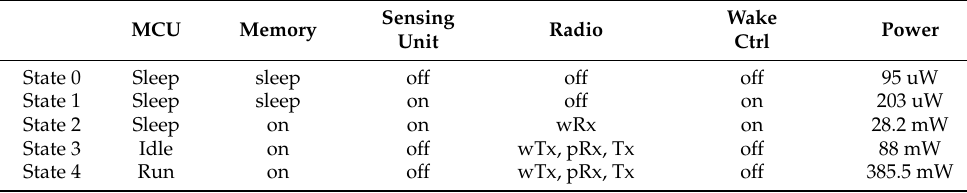
Table 2. Power consumption of the function blocks of the sensor